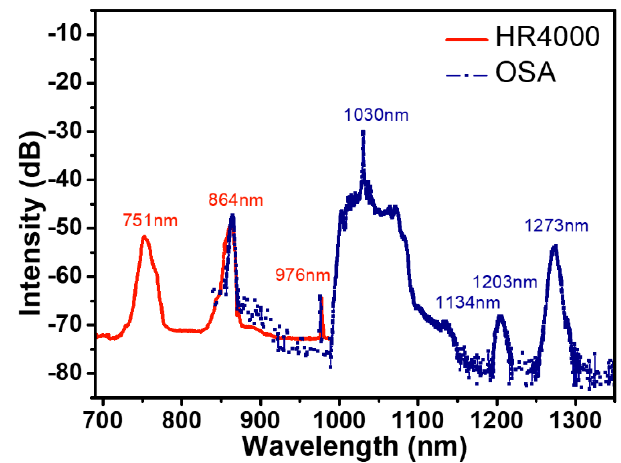
Figure 3. The spectrum measured by optical spectrum analyzer (blue curve) from 850 to 1350 nm and by HR4000 (red curve) from 700 to 1000 nm on a logarithmic scale. The spectral resolution for the HR4000 is 0.27 nm. Five parametric sidebands were generated, such as 751, 864, 1134, 1203, and 1273 nm, with the fundamental wave at 1030 nm. The peak at the wavelength of 976 nm indicates the residual pump laser.